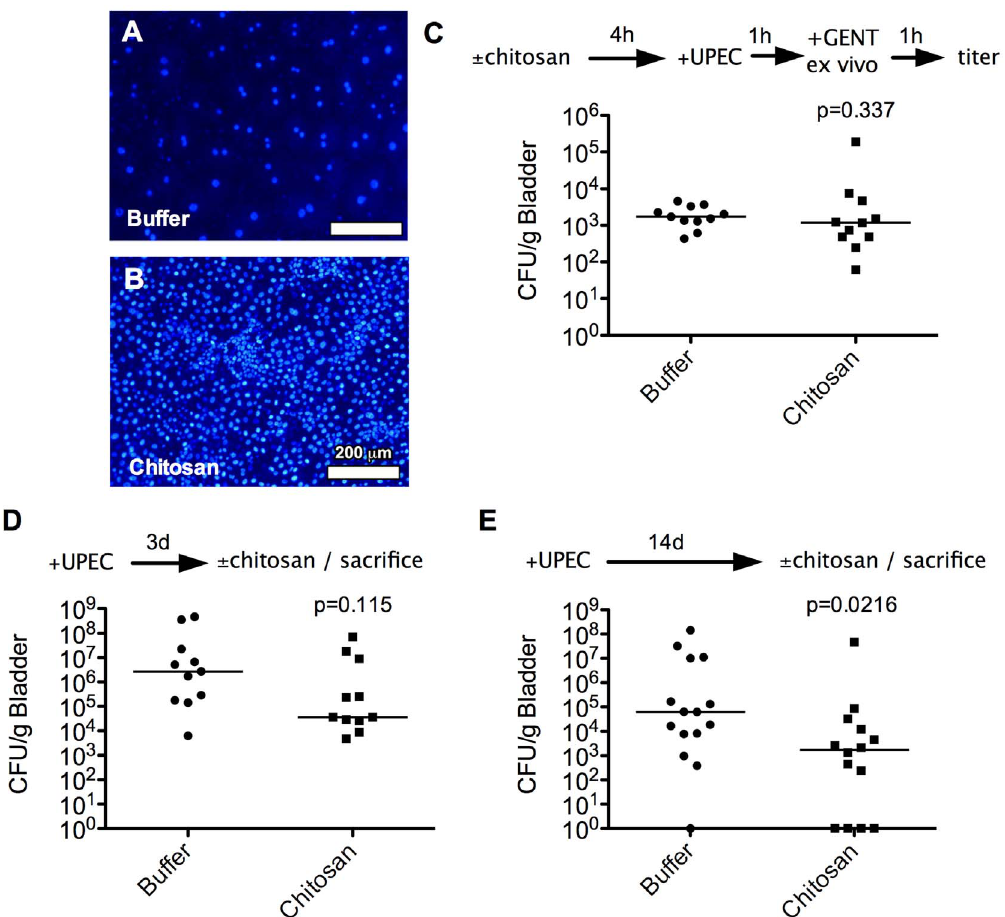
Figure 2. Chitosan-induced exfoliation of superficial BECs and analysis of UPEC reservoir populations. ( A and B ) Fluorescent images show the lumenal surfaces of mouse bladders fixed and stained with Hoechst dye following 20-min treatments with ( A ) phosphate buffer (pH 4.5) alone or with ( B ) 0.01% chitosan. Representative images of three independent experiments performed in duplicate. ( C ) The bladders of adult female CBA/J mice were inoculated with UTI89 via transurethral catheterization 4 h after a 20-min treatment of the mouse bladders with chitosan or phosphate buffer alone. Internalized bacteria were enumerated 1 h after initiation of the infection using ex vivo gentamicin protection assays. ( D and E ) Graphs show bacterial titers present in the bladders of mice treated with phosphate buffer or chitosan just before collection at ( D ) 3 d or ( E ) 14 d post-inoculation with UTI89. Bars indicate median values for each group; n=11 mice. P values indicated were determined by the Mann-Whitney U-